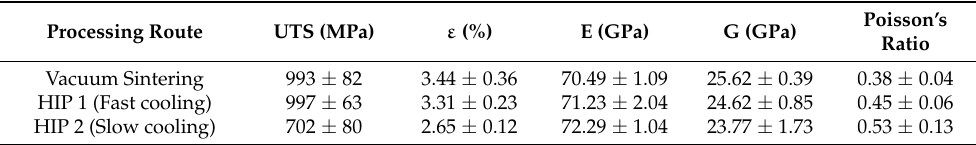
Table 3. Mechanical results of the Ti35Nb2Sn